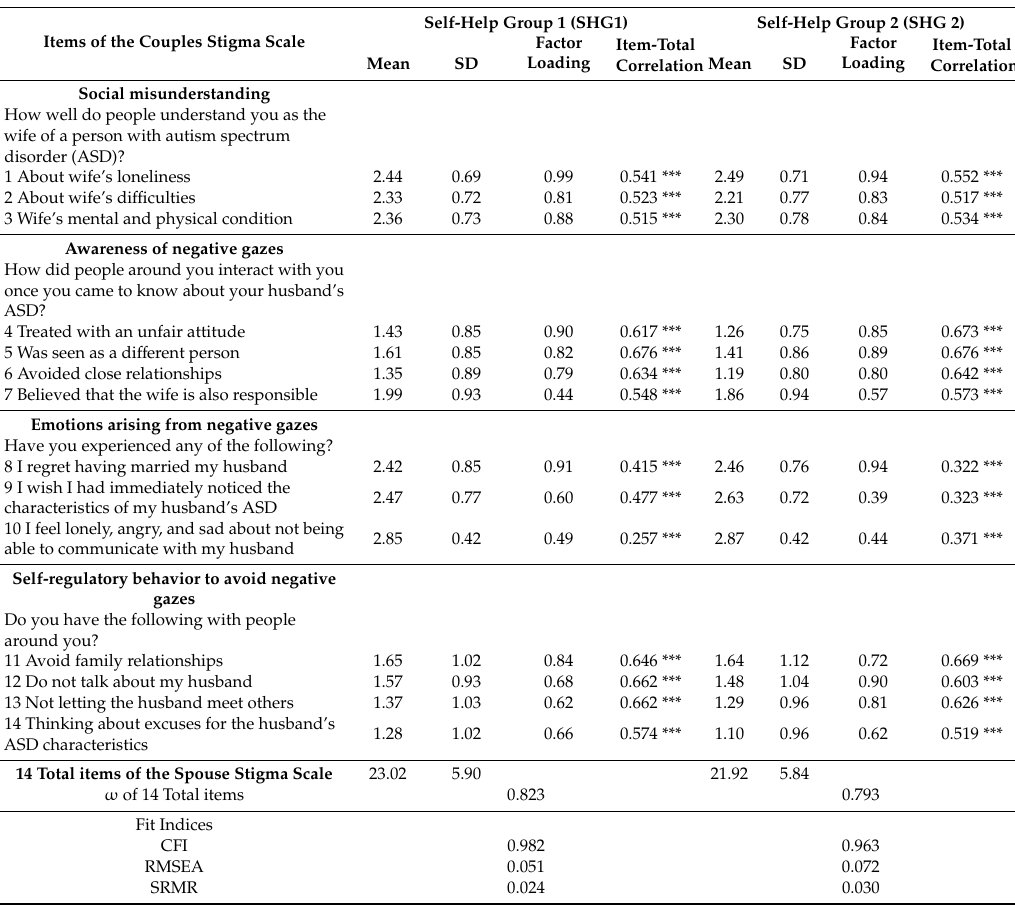
Table 2. Structural validity of the Couples Stigma Scale. Items of the Couples Stigma